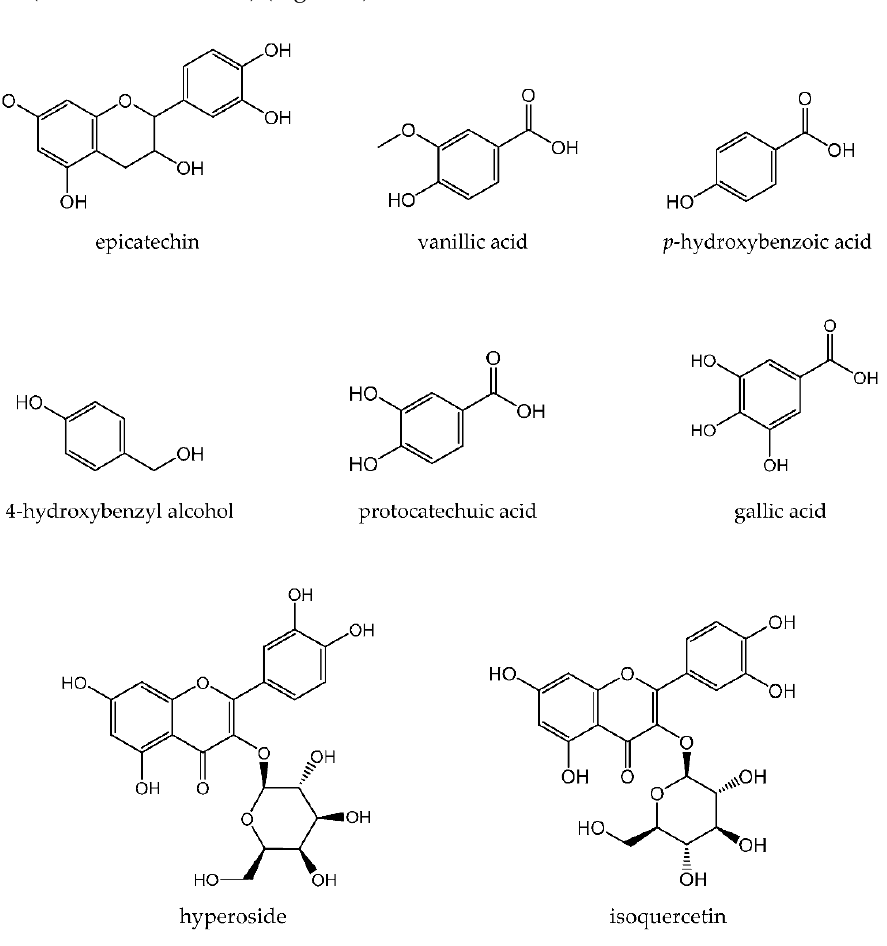
Figure 3. Chemical structures of the eight selected